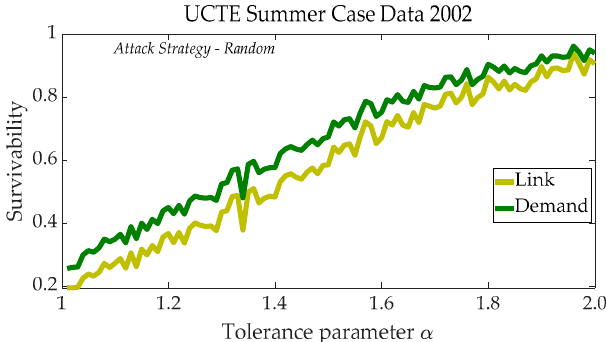
Figure 4. The UCTE (Union for the Co-ordination of Transmission of Electricity) summer case data 2002 curve using MATCASC (cascading line outages analyse tool for power grids). The expected load of the node n Pi in the PN is shown in Equation